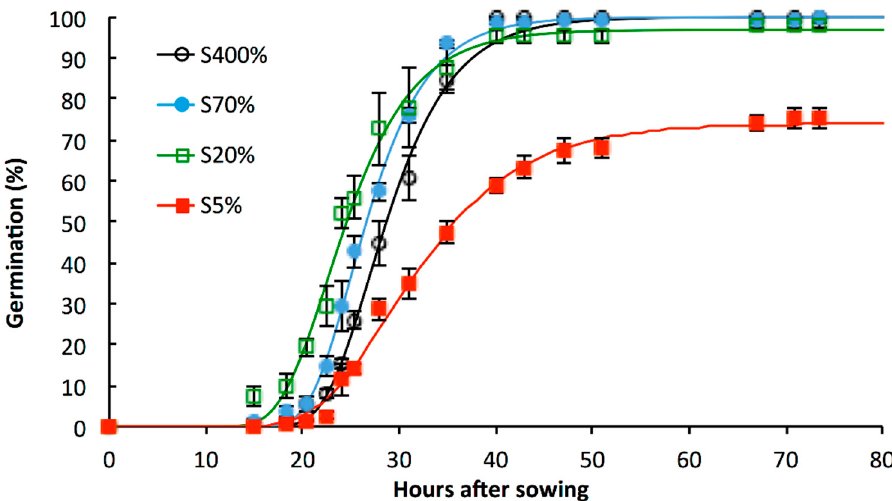
Figure 1. Evolution of germination percentage of Brassica napus seeds obtained from plants well S supplied and grown under S-limited conditions. Values shown by symbols correspond to means ± SE (n = 3). Seeds were obtained from plants subjected to plethoric S nutrition (400% of plant S needs provided, S400% seeds) or subjected to a S limitation from the beginning of plant growth with 70%, 20% and 5% of plant S needs provided (S70%, S20% and S5% seeds, respectively). The curves are calculated from the non-linear Gompertz regression model [14]. The germination indexes determined from these observations are given in Table 2.